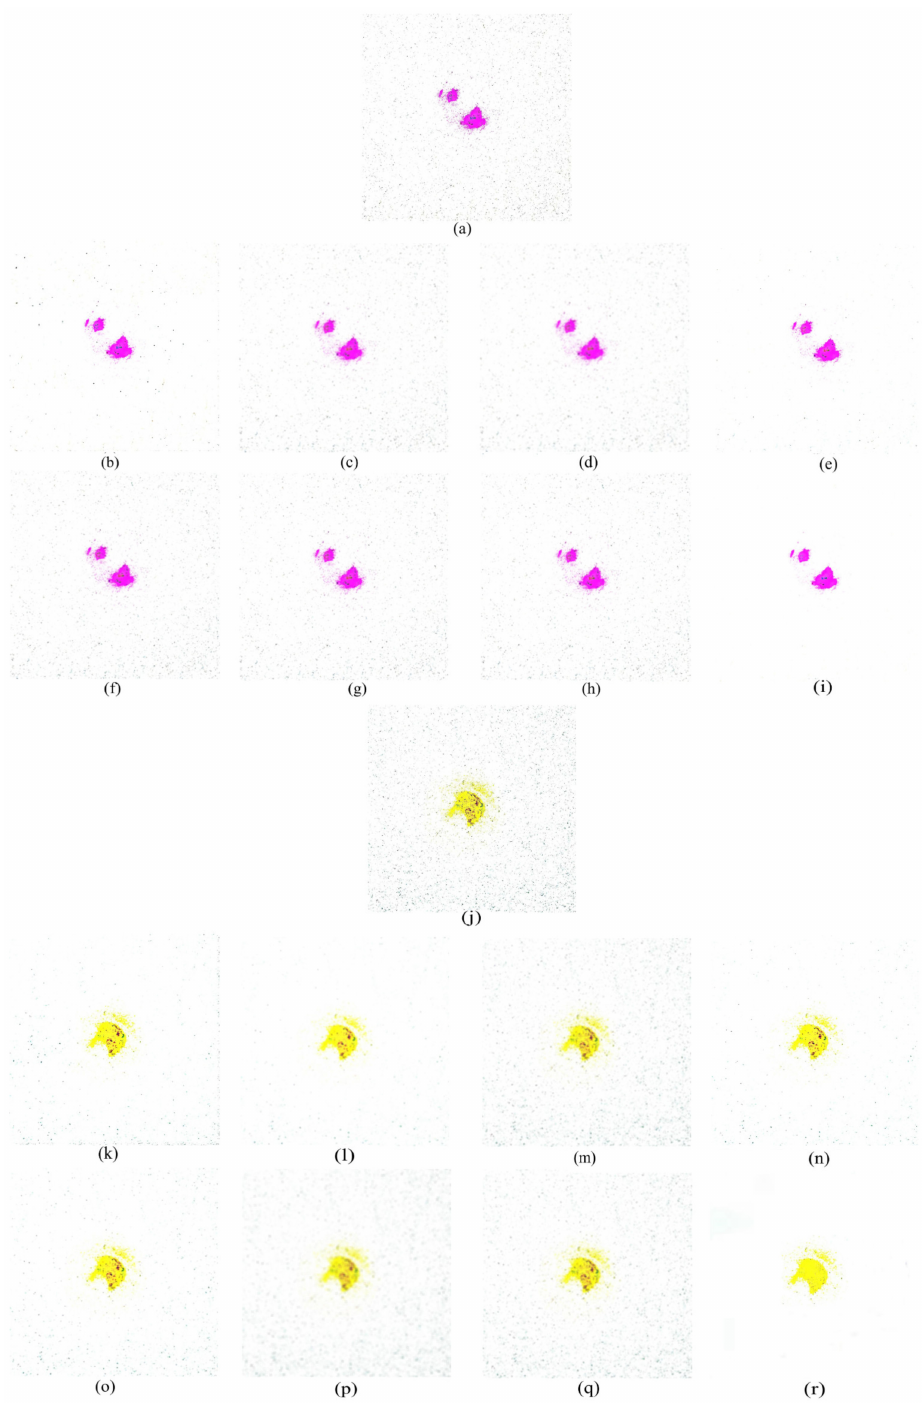
Figure 17. Visual comparison of all the filtering algorithms. ( a ) Noisy image 1; ( b ) DAMF; ( c )